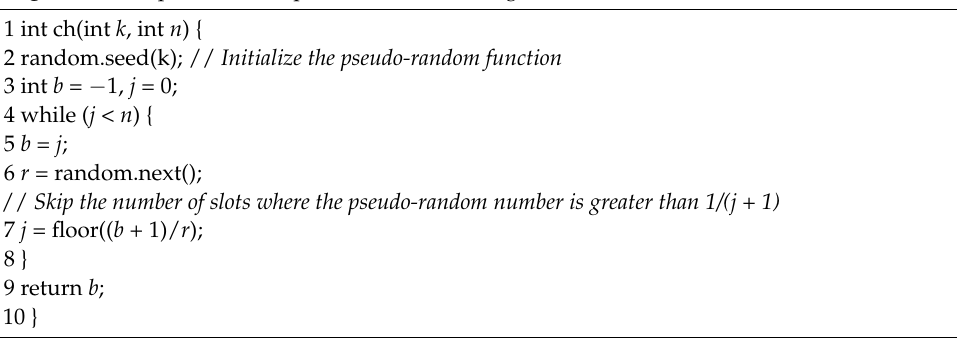
Algorithm 2: Optimized Jump Consistent Hash